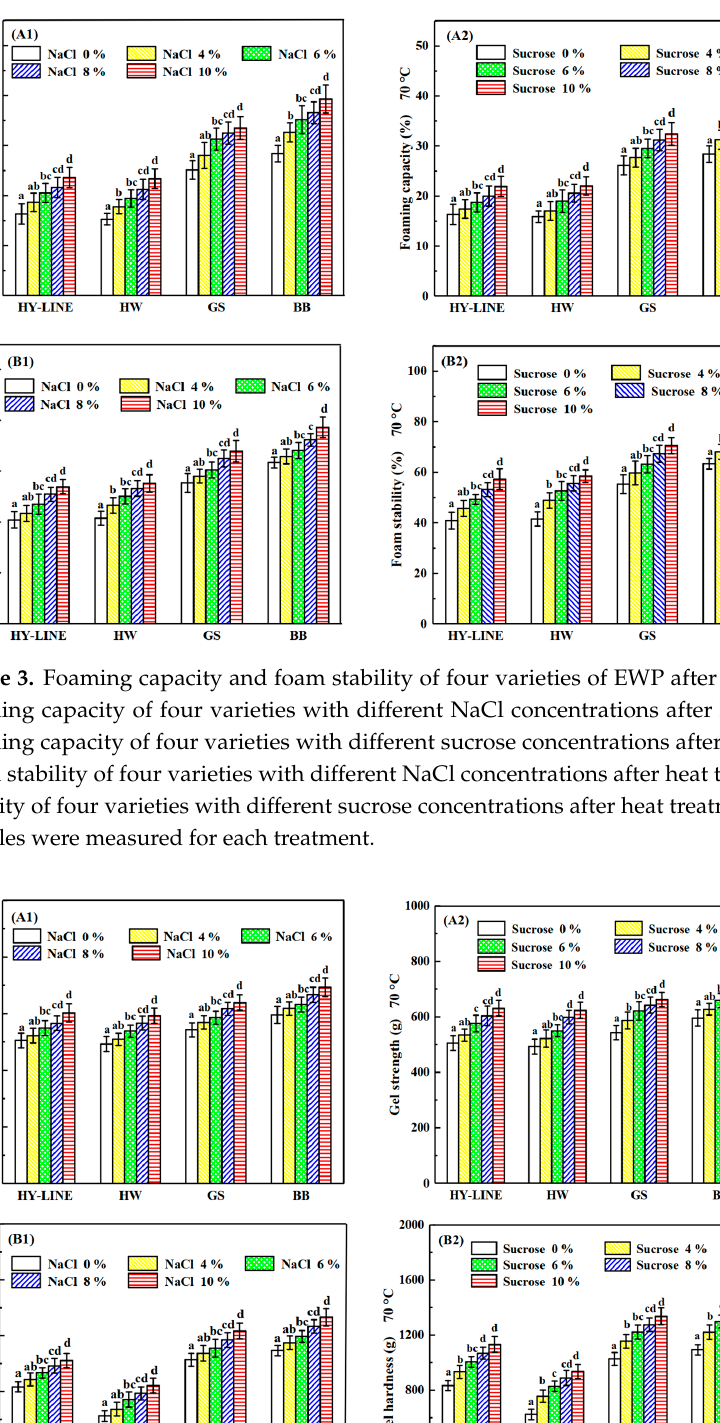
capacity and foam stability of BB and GS EWs were significantly higher than those of HY- LINE and HW EWs ( p < 0.05). For EWs without NaCl or sucrose, the foaming capacity was as follows: HY-LINE, 16.30%; HW, 15.27%; GS, 25.13%; BB, 28.38%. The values of foam stability were as follows: HY-LINE, 40.84%; HW, 41.51%; GS, 55.32%; BB, 63.38%. According to Figure 3, the foaming capacity of EWs with added NaCl was higher than that of EWs with sucrose; however, the foam stability of EWs with sucrose was higher than that of EWs with NaCl. The foaming capacity of EWs containing 10% NaCl was the highest: HY-LINE, 23.59%; HW, 23.36%; GS, 33.52%; BB, 39.29%. The foam stability of EWs containing 10% sucrose was the highest: HY-LINE, 57.22%; HW, 58.49%; GS, 70.51%; BB, 80.03%. When EW is whipped, air enters the liquid to form a foam of EWP and water [28]. Foams of EW are used in foods such as marshmallows and cakes [29]. The foaming properties of EW are affected by many processing factors. With an increase in the ovalbumin content, the foaming capacity and foam stability of EW were enhanced, whereas adding sucrose or NaCl to EW can improve the foam stability and thermostability of EW [30]. In Figure 2(B1,B2), the ovalbumin content of EWs with different concentrations of NaCl or sucrose was different, and the ovalbumin content of BB and GS EWs was higher than that of the other two varieties ( p < 0.05), supporting the concept that the ovalbumin content is related to the foaming properties. With an increase in the ovalbumin content, the foaming capacity and foam stability increased. 3.4. Differences in the Gel Properties of the Four Varieties of EWs under Heat Treatment The heat-induced gels of different varieties of EWs are shown in Figure 4. The gel strength of HY-LINE, HW, GS and BB EWs was 505.31 g, 492.68 g, 542.94 g and 595.08 g, respectively. Furthermore, the gel hardness of HY-LINE, HW, GS and BB EWs was 832.98 g, 624.31 g, 1027.41 g and 1093.07 g, respectively. Gel strength and gel hardness are af- fected by temperature and heating time. Adding NaCl or sucrose increased the heat re- sistance of EW, and the effect of adding sucrose was better than that of adding NaCl be- cause the viscosity of liquid EW was increased by the addition of sucrose. When the con- centration of sucrose in the EWs reached 10%, the gel strength was as follows: HY-LINE, 631.21 g; HW, 623.67 g; GS, 662.11 g; BB, 711.15 g. Gel hardness was recorded as HY-LINE, 1132.98 g; HW, 935.64 g; GS, 1336.74 g; BB, 1413.69 g. Moreover, the gel strength and gel